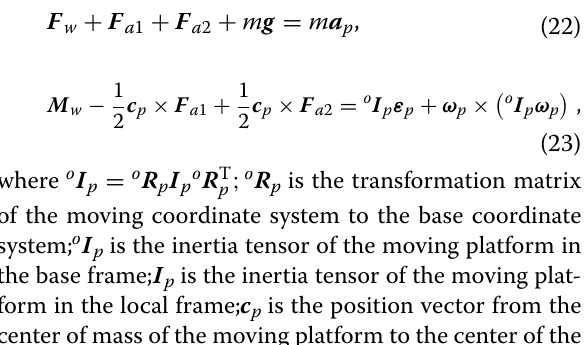
Figure 8 Force analysis of three drive